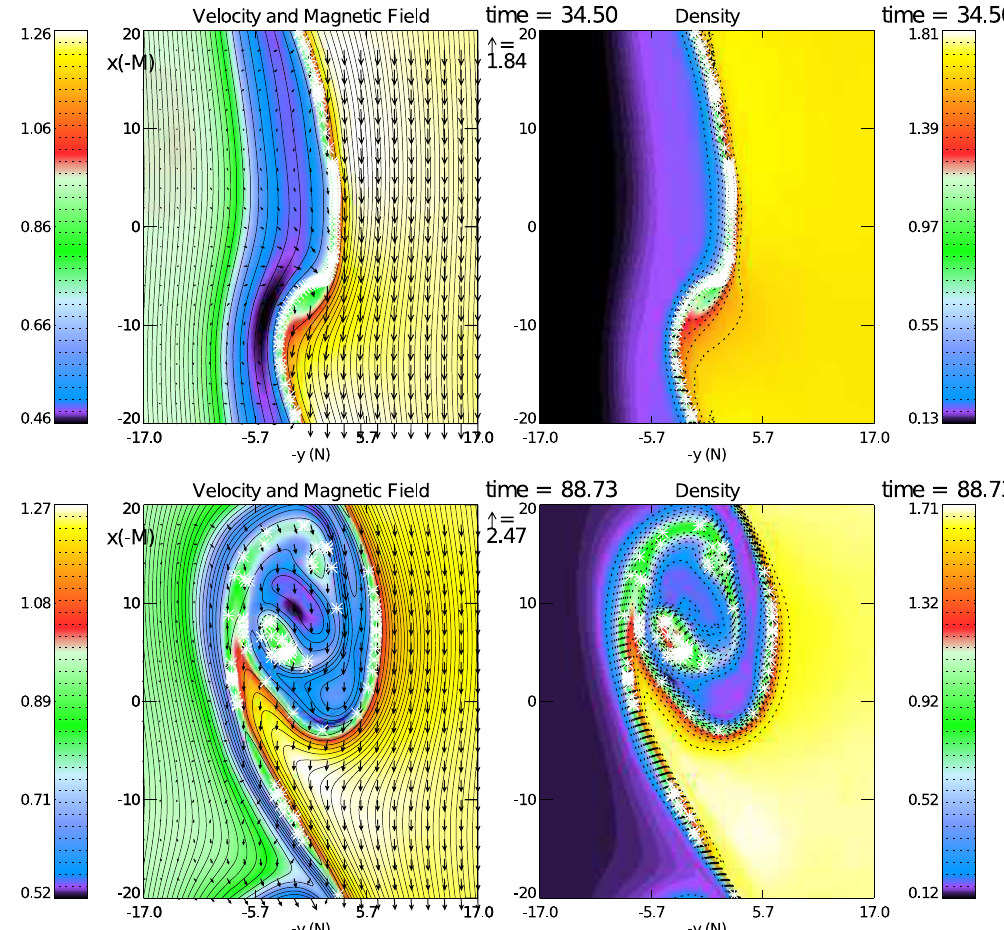
Fig. 7. Example of the onset and evolution of the KHI vortex simulated by local MHD simulations for Event 3. The top- and bottom-left figures show the velocity vectors represented by the arrows and magnetic field depicted by color. The top- and bottom-right figures show the density represented by the color. The two top figures show the onset of the vortex and the bottom two figures represent how the vortex has evolved over time. The asterisks in the figures represent fluid elements. All values listed are in normalized units. The positive x axis is up and the positive y axis is right.